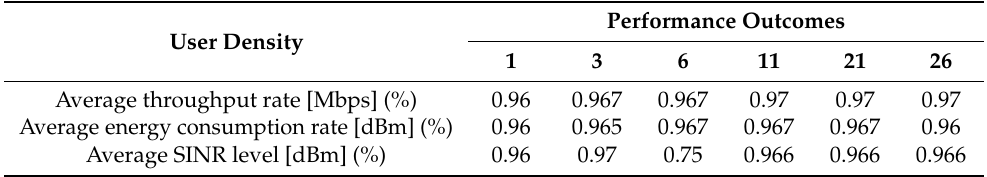
Table 6. The average accuracy of the target clusters and the user density in different learning